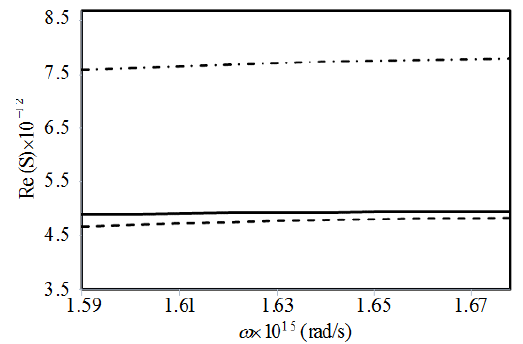
Fig. 4 Real part of the sensitivity for TE 0 versus frequency with 5 =6.089 10    Siemens at different values of d . Dash line is when d = 85 nm, solid line is when d = 75 nm, and dash-dotted line is when d = 55 nm.